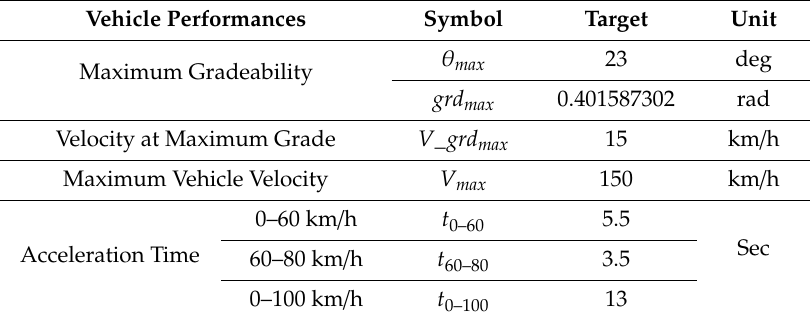
Table 5. Targets for vehicle dynamic